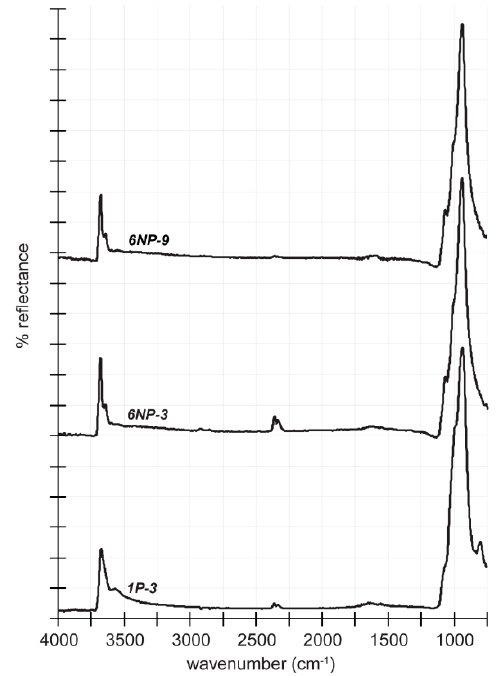
Figure 4. FTIR spectra for serpentine matrix in samples 6NP and 1P.